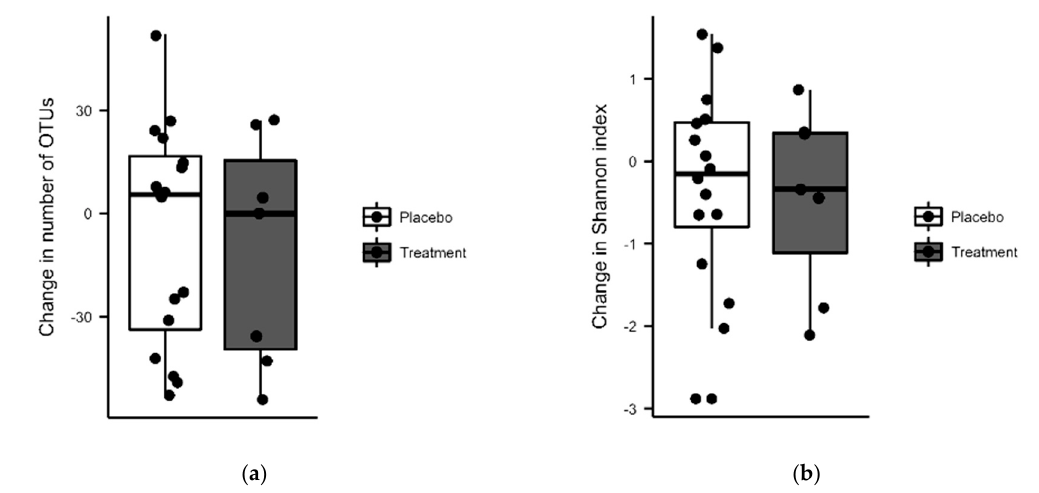
Figure 2. No significant treatment effects on microbiota was found in colonic biopsies from baseline and week 16 (treatment n = 7, placebo n = 16) in analyzes of number of operational taxonomic units (OTUs) ( a ), Shannon microbial diversity index ( b ).